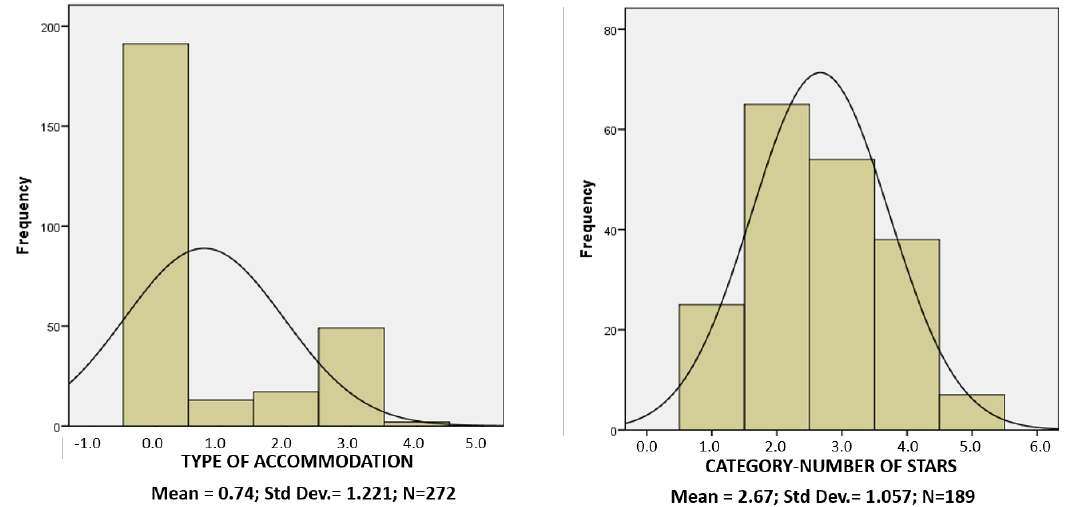
Figure 1. Types and categories of accommodation in the south of Gran Canaria.